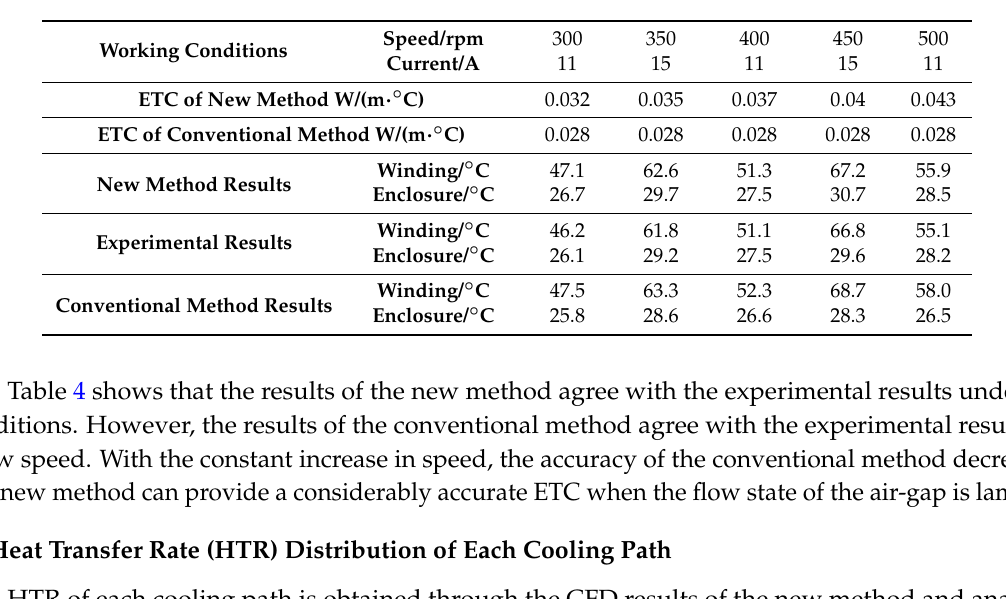
Table 4. Verification of equivalent thermal conductivity (ETC) under various working